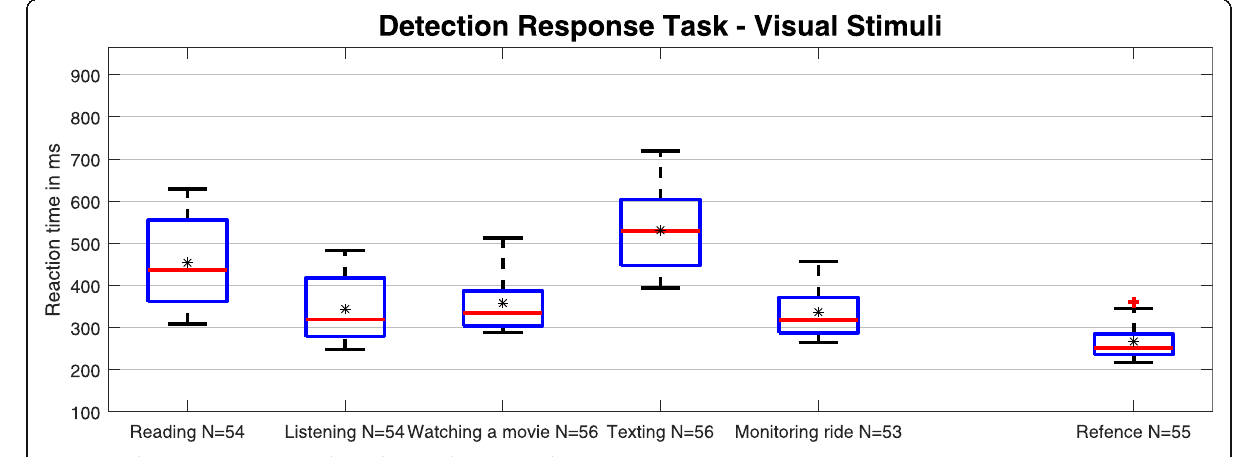
Fig. 7 Boxplot representation DRT depending on the examined NDRT in